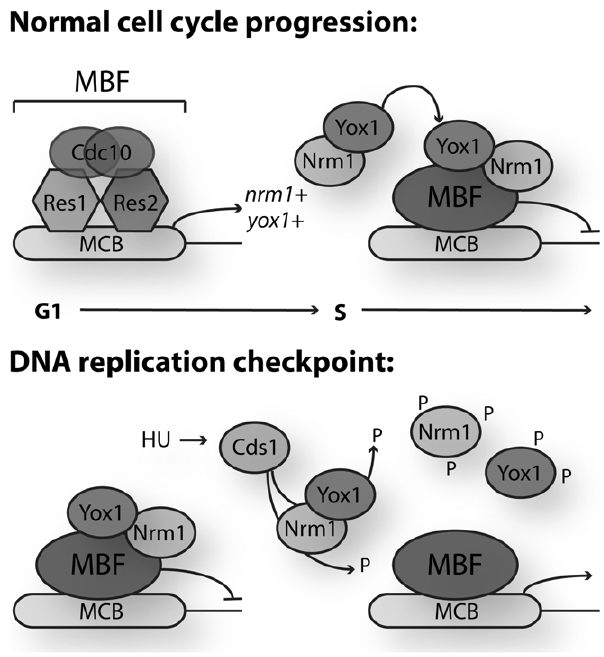
Figure 7. Regulation of Yox1p during the cell cycle and in response to DNA replication stress. Inactivation of MBF-dependent transcription during late S phase of the normal cell cycle is dependent on binding of the co-repressor Yox1p through Nrm1p to the core components of the MBF transcription factor (upper panel). Activation of the DNA replication checkpoint and maintenance of the MBF transcriptional program following HU challenge occurs via phosphor- ylation and inactivation of both Nrm1p and Yox1p by the DNA replication checkpoint effector kinase Cds1 (lower panel).